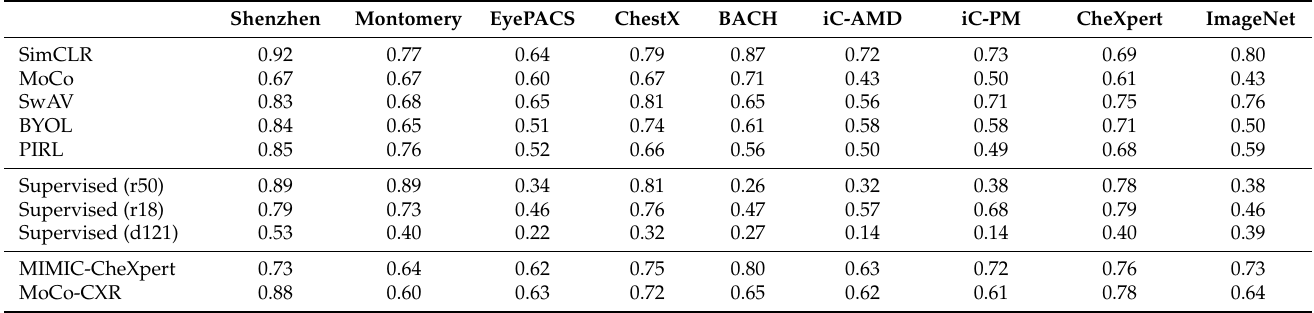
Table A5. Perceptual distance values, as measured by the LPIPS (Learned Perceptual Image Patch Similarity) metric using the SqueezeNet architecture, for the reconstructed images for each model for each dataset. A low value close to 0 indicates a strong perceptual similarity between the original and reconstructed